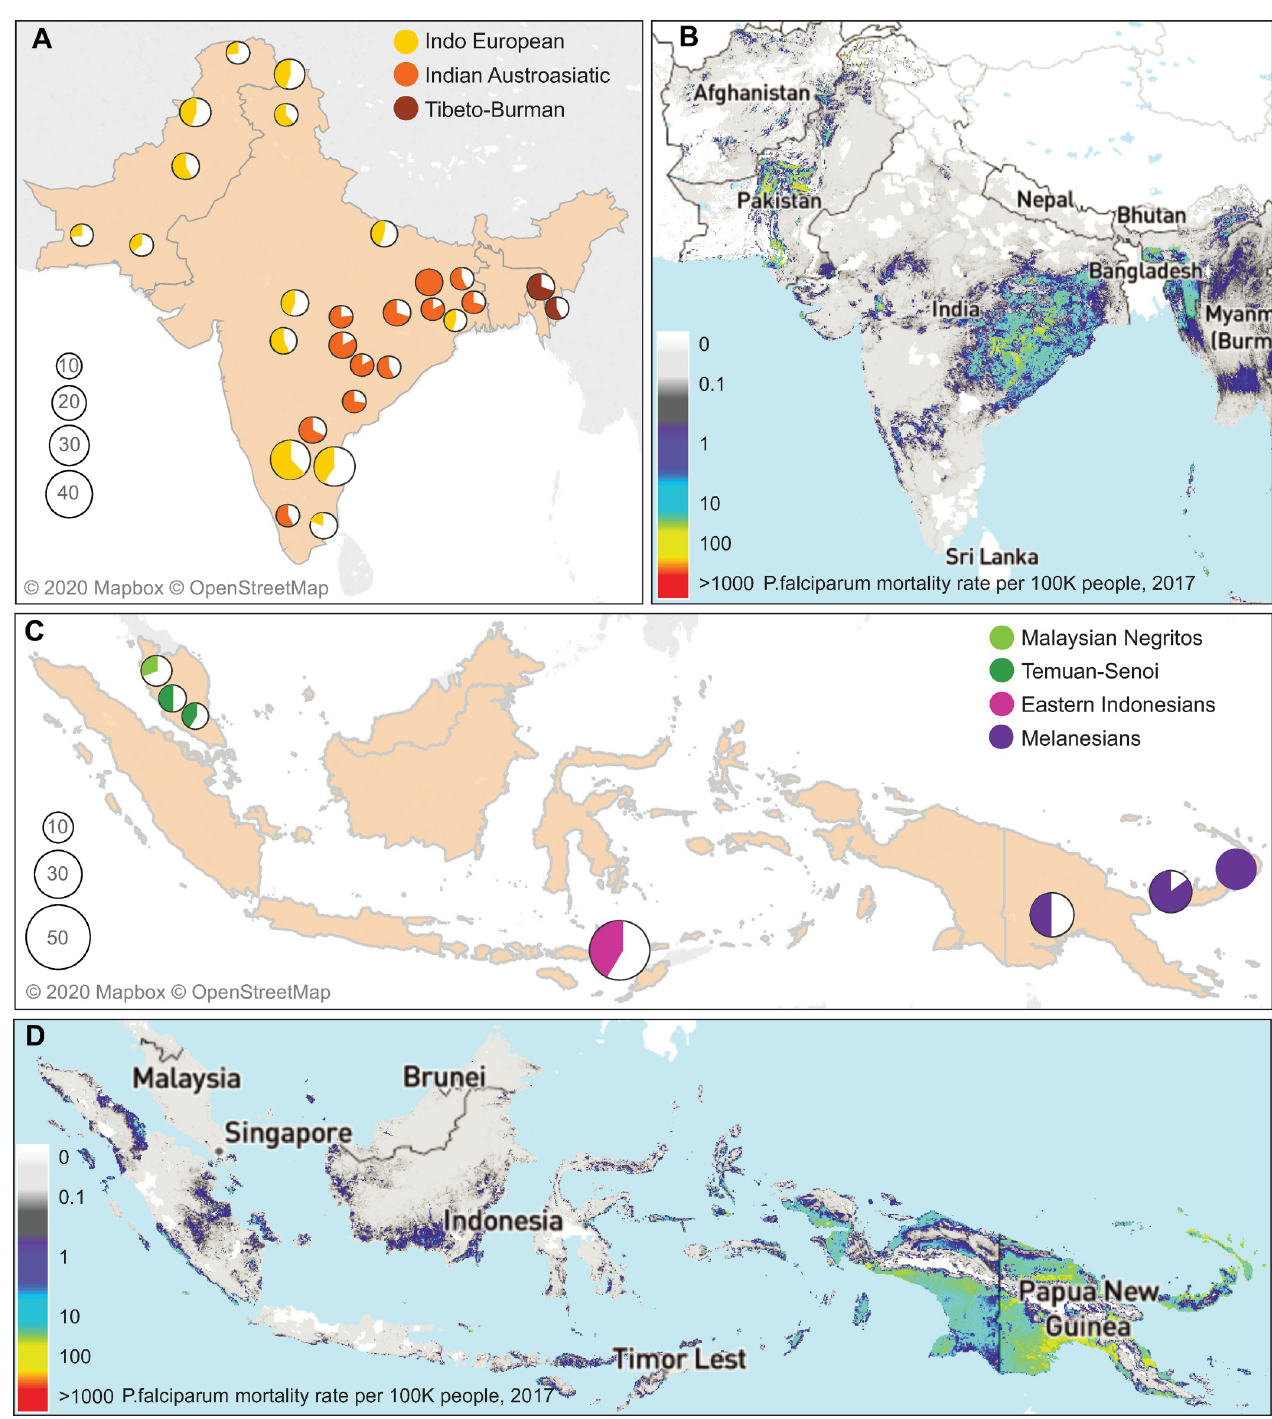
Fig 4. Frequency distribution of the LS haplogroup and the malaria mortality rate. For the ethnic groups living in South and Island Southeast Asia, the haplotype frequency of the LS haplogroup (A and C) and the malaria mortality rate (B and D) are shown on the geographic map. The pie charts show the frequency of the LS haplogroup in each ethnic group with a sample size equal to or greater than 10. The colors in the pie charts represent the population group which the ethnic group belongs to. The mortality rate per 100,000 people is shown as colors in the map, which was retrieved from the malaria atlas project [45]. The haplotype frequencies for all ethnic groups are provided in the S8